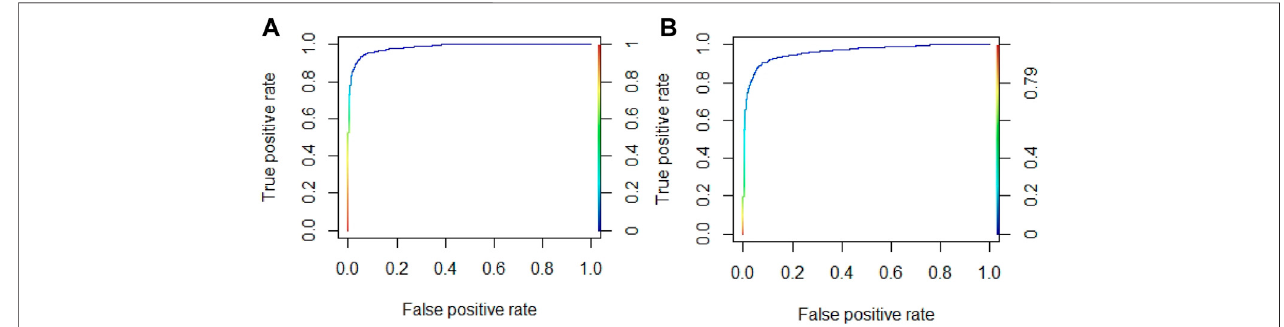
FIGURE 7 | The ROC curve of optimal algorithm parameters for Cu 2+ and K + ligands. Note: (A) is Cu 2+ ligand; (B) is K + ligand.